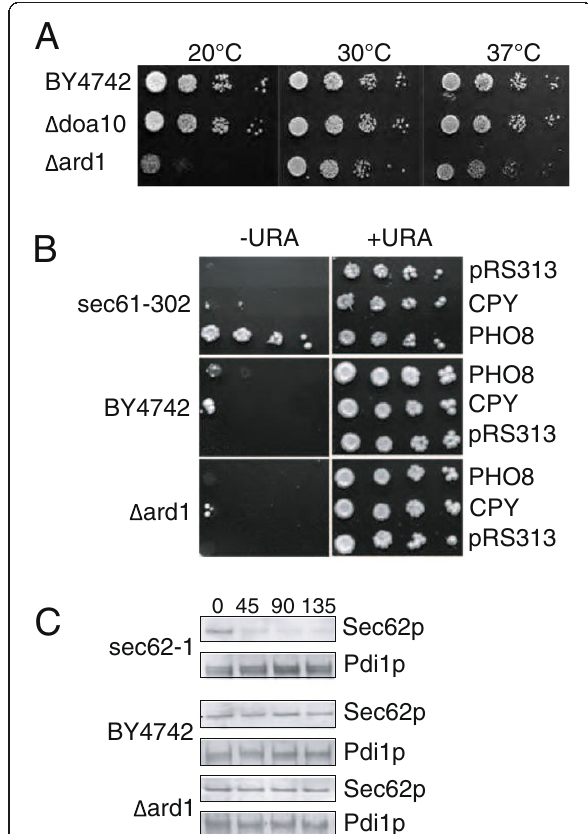
Figure 7 Δ ard1 yeast have a growth defect, but no translocation defect or Sec62p instability. ( A ) Wildtype (BY4742) and the indicated mutant cells were diluted on YPD plates and growth monitored at the indicated temperatures. ( B ) Wildtype, sec61-302 and Δ ard1 cells were transformed with empty vector (pRS313), or plasmids expressing PRC1-URA3 (CPY) or PHO8-URA3 (PHO8) fusions. Growth in absence ( − URA) or presence (+URA) of uracil was monitored on plates at 30°C. Growth in the absence of uracil indicates a defect in translocation into the ER. ( C ) Wildtype (BY4742) and the indicated mutant cells were grown to early log phase, cycloheximide added at time 0, and samples taken at the indicated chase times. Cells were lysed, proteins resolved by SDS PAGE and Sec62p and Pdi1p (as loading control) detected by